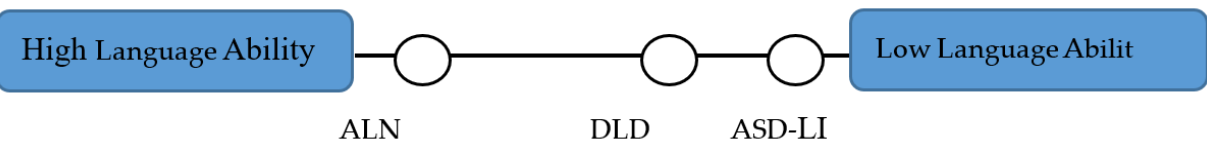
Figure 5. An iconic representation of language ability of children with ASD and DLD.